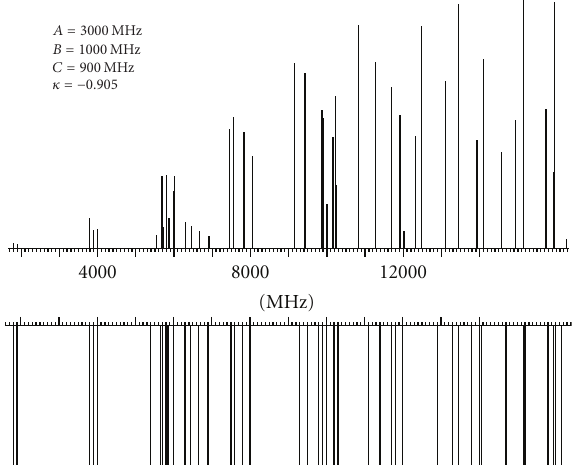
F 10: e actual rigid rotor spectrum arising from the rotational constants given (top), compared to the complete rigid rotor spectrum generated using the same rotational constants and the simple formulae given in Table 1